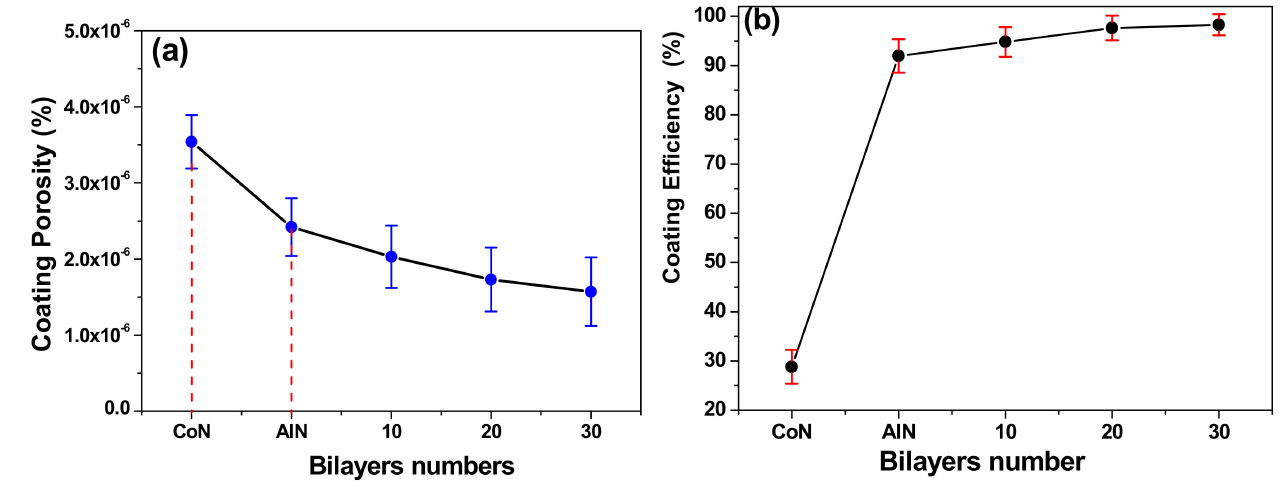
Figure 14. Electrochemical properties: ( a ) Porosity factor of coatings and ( b ) coating efficiency